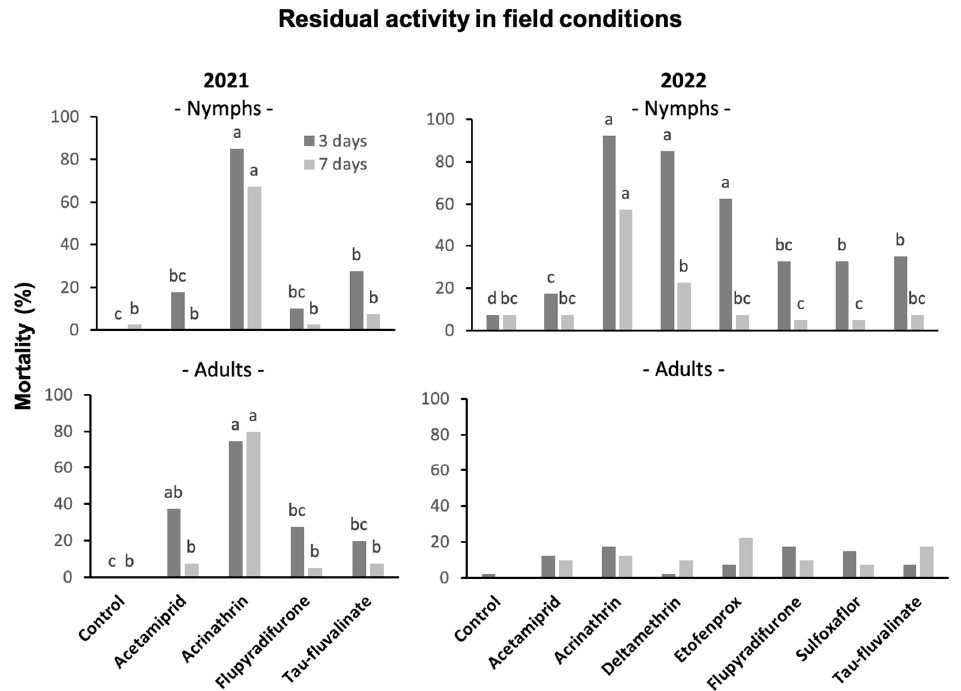
Figure 6. Mortality of S. titanus nymphs and adults confined on leaves three and seven days after insecticide application in field conditions in 2021 and 2022. Different letters above the columns with the same color indicate significant differences at the t ‐ test ( α = 0.05).